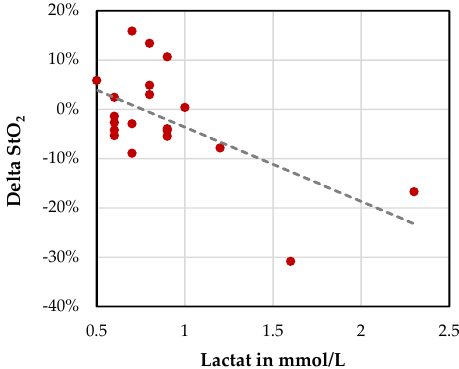
Figure 6. Distribution of lactate values after 30 min and changes of liver oxygenation after GDA clamping (Delta StO 2 = StO 2 [30 min after clamping] - StO 2 [before clamping] ).